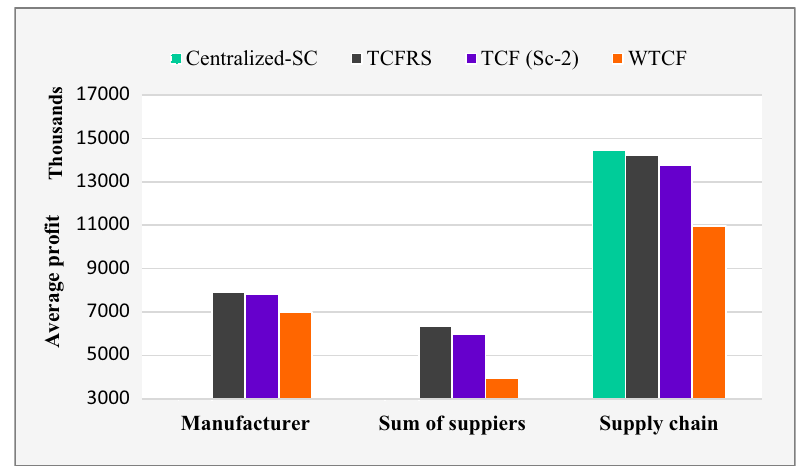
Fig. 11 A comparison between TCFRS contract, TCF contact in Sc-2 , WTCF case, and centralized structure for test problems of size 2